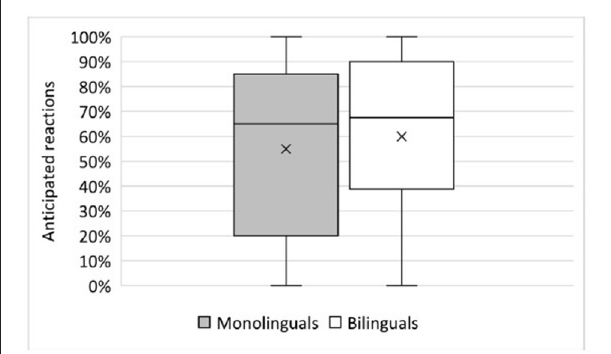
FIGURE 4 | Proportion of anticipatory reactions (before hearing the second object) in the sentence-picture matching task in monolinguals and bilinguals. x =